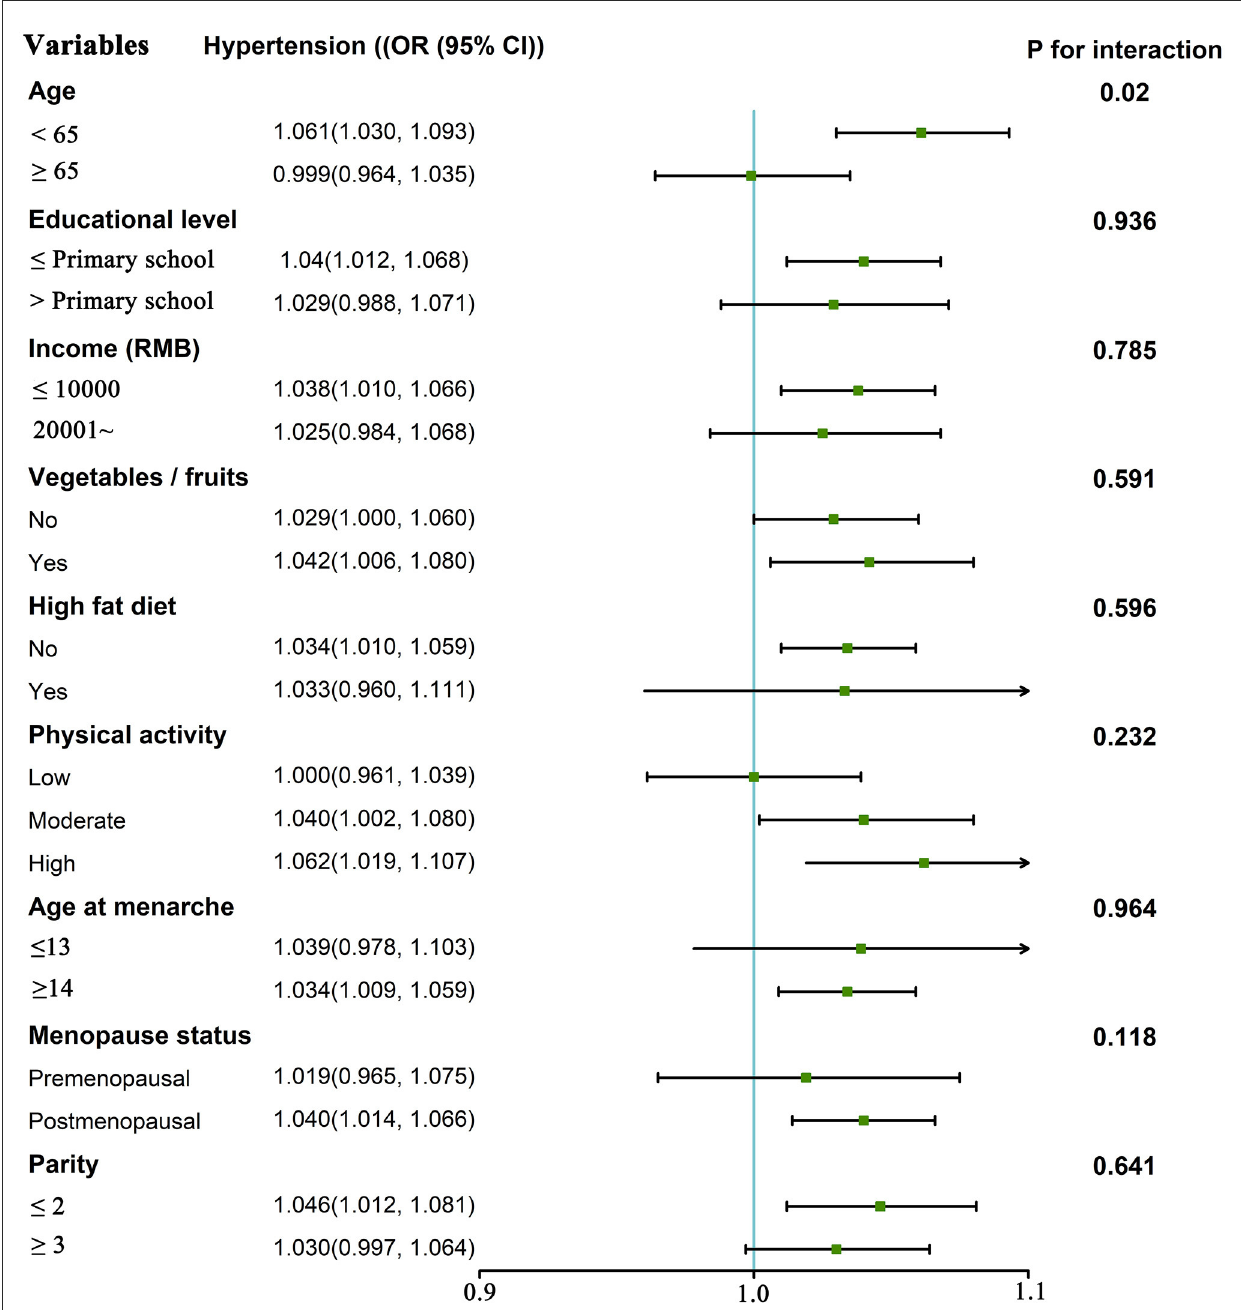
FIGURE3 The odds ratio of hypertension (and 95% CI) associated with first pregnancy age according to potential modifiers. Adjusted for age, marital status, education level, family per capita yearly income, smoking, alcohol consumption, physical activity, adequate intake of vegetables and fruits, high-fat diet, family history of hypertension, BMI, age at menarche, menopause status, breastfeeding, use of oral contraceptive pills, gestational hypertension, gestational diabetes mellitus, parity, and age at last birth (unless stratified by the respective